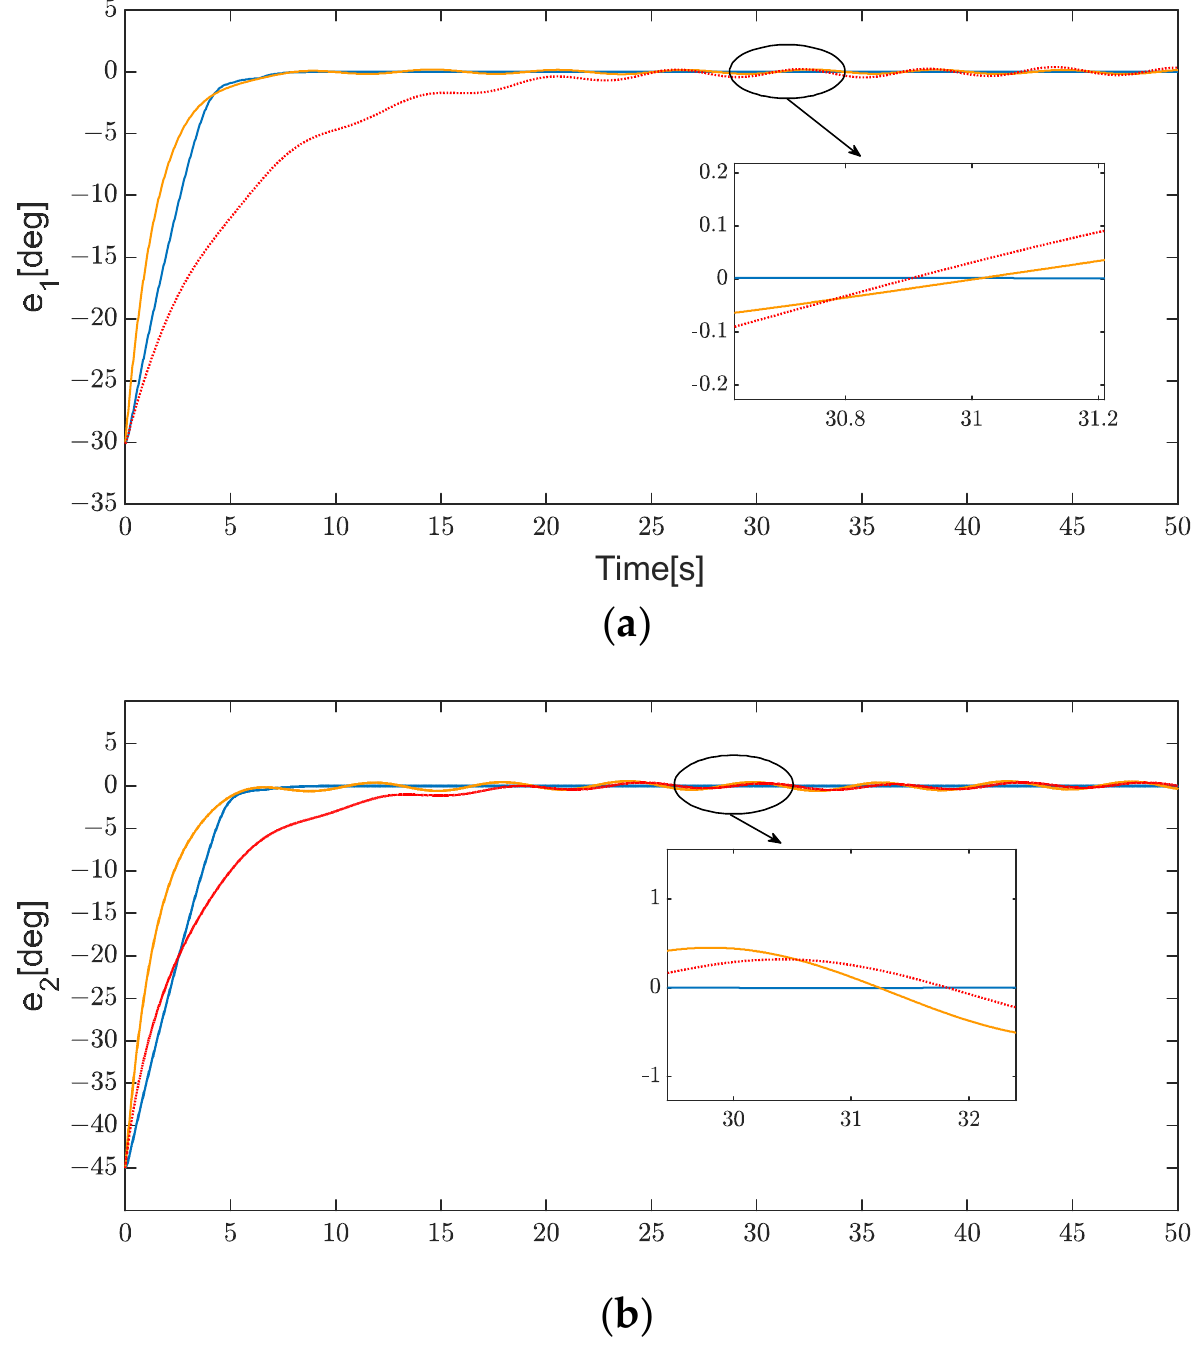
Figure 11. Comparison of angular position error to [26,33] in case 2: the [26] scheme (yellow solid line), the [33] scheme (red dash line), the proposed scheme (blue solid line); ( a ) Joint 1. ( b ) Joint 2.